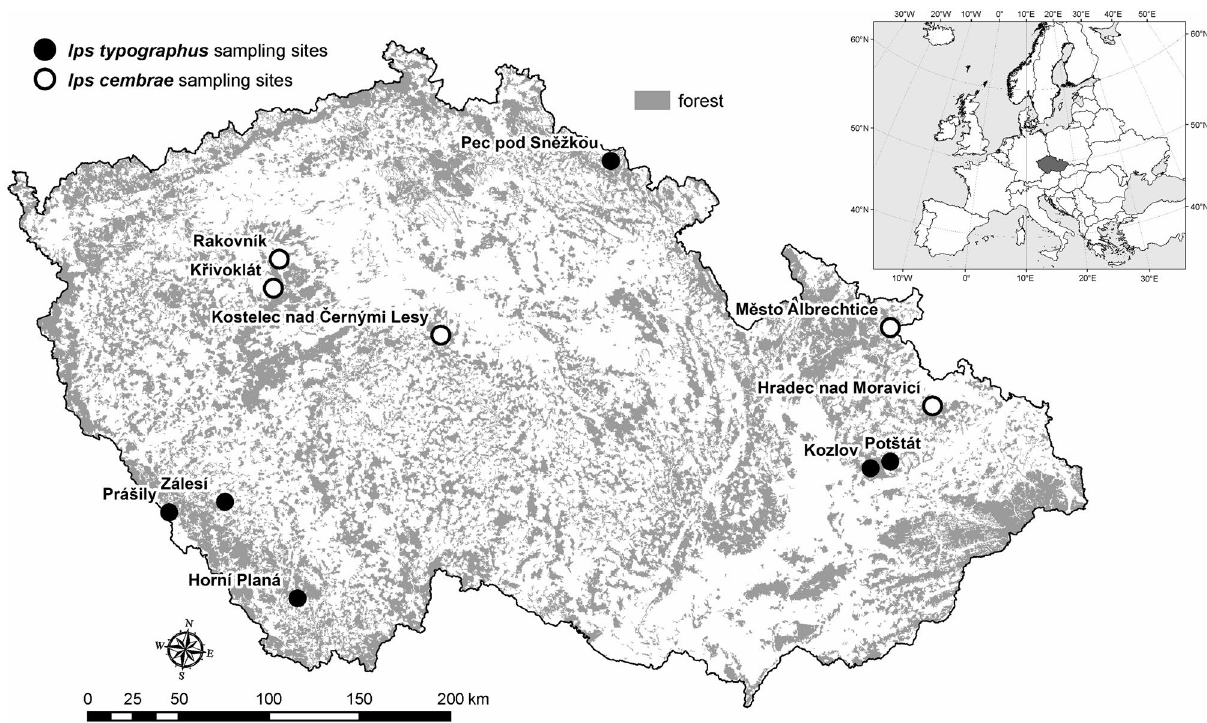
Figure 1. Sites in the Czech Republic where females of I. typographus and I. cembrae were collected in the period of 2009–2016. Sites are indicated by black circles for I. typographus and by white circles for I.